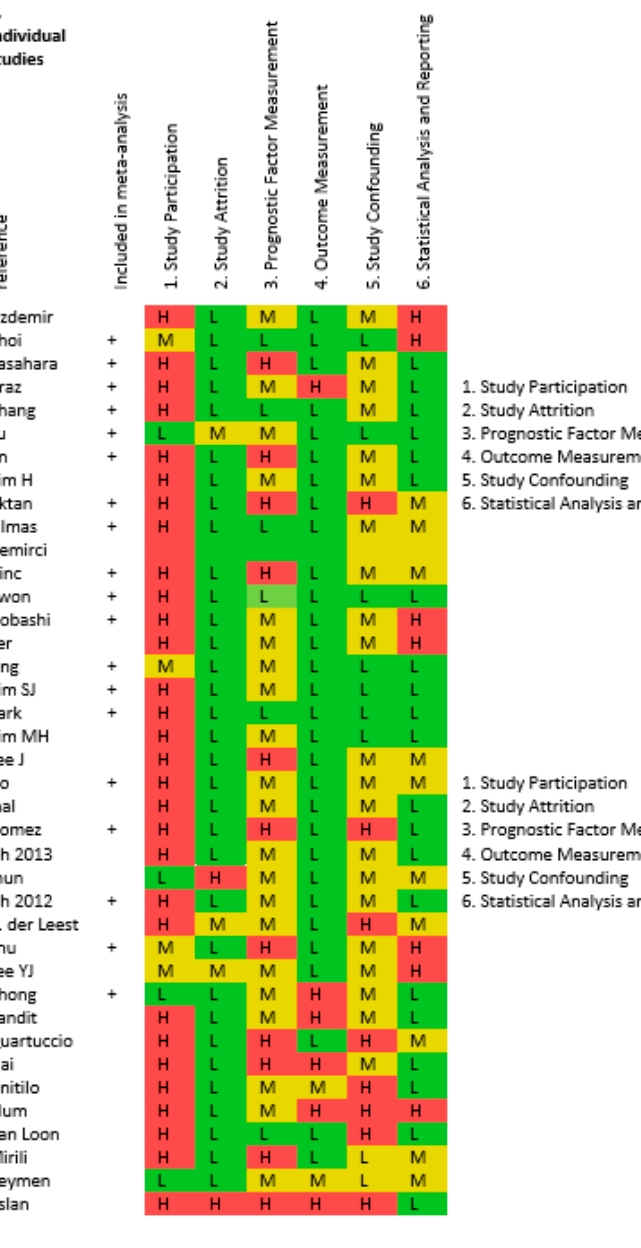
Figure 2. Risk of bias according to the Quality in Prognostic Studies (QUIPS) tools. Individual studies are shown in ( a ), results from all studies in ( b ), and results from studies included in the meta-analysis in ( c ).